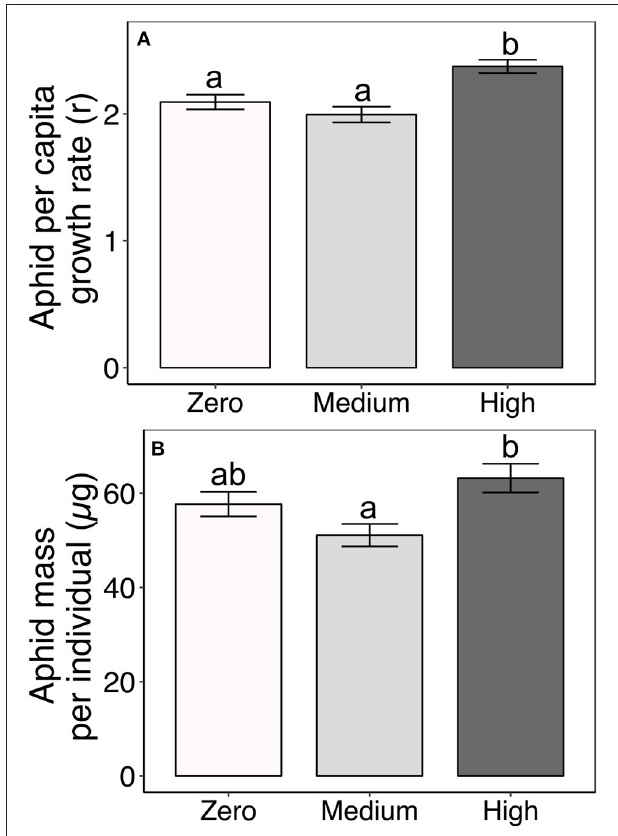
FIGURE 2 | Effects of AMF inoculum availability on (A) per capita growth rates of aphids (r over 6 days) and (B) average dry mass of individual aphids reared on four milkweed species. Sample sizes are 60 populations of aphids ( = replicate plants) for aphid per capita growth rates and range from 55 to 59 populations for average individual aphid mass per AMF treatment. Bars display the mean ± 1SE. Different letters indicate significantly ( P < 0.05) different means (Tukey post-hoc test of the